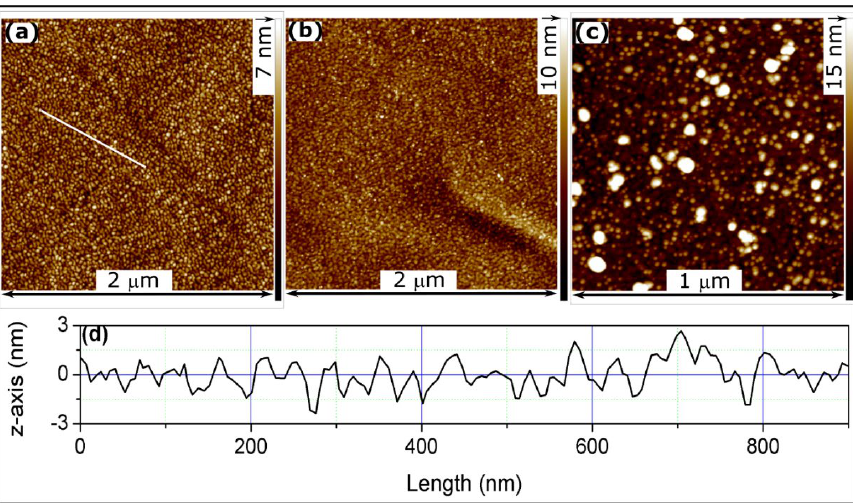
Figure 4. The atomic force microscope (AFM) topography images of NiTi sample’s surface (forces 500 pN) ( a ), Alu10 sample’s surface (forces 500 pN) ( b ) and Pt100 sample’s surface (the maximum interaction force was 5 nN; measured simultaneously with local conductivity (Figure 5c)) ( c ). The white line in subfigure ( a ) indicates positions of the cross section analysis ( d ).